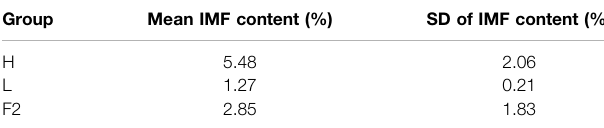
TABLE 1 | Sample IMF content